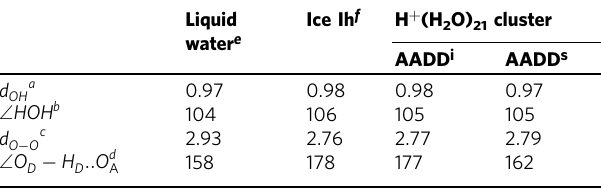
a The average O-H bond length of the water molecule. b The average H-O-H angle of the water molecule. c The average hydrogen-bond length in terms of the oxygen – oxygen distance between two hydrogen-bonded water molecules. d The average hydrogen-bond angle formed between the O D -H D bond and the H D ..O A direction. e The data were calculated at the fragment-based CCD/aug-cc-pVDZ level from ref. 42 . f The data were calculated at the fragment-based MP2/aug-cc-pVDZ level from ref. 48